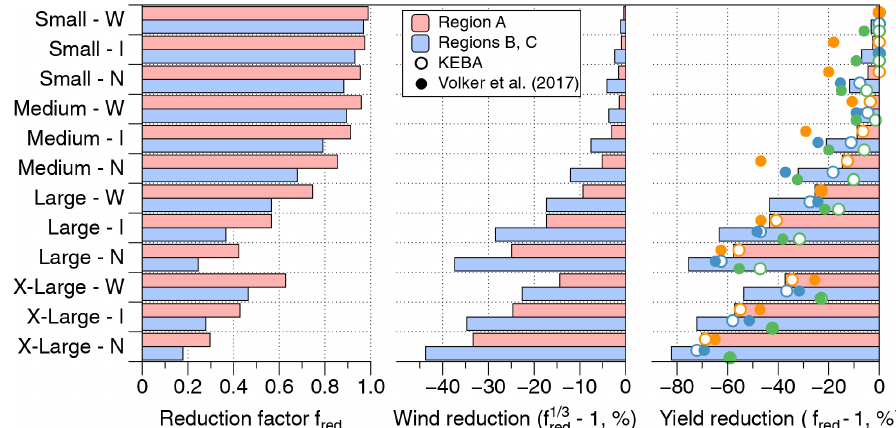
Figure 4. The value of the reduction factor f red for the case in which v < v rated (Eq. 9) for the different scenarios as well as the implied − 1, and the relative reduction of yield, f − 1, derived directly from the value of f relative reduction in wind speed, f 1 / 3 red red . The circles red in the right panel refer to the actual estimates that include the information of the wind speed histograms (open circles: KEBA; full circles: Volker et al., 2017), with the colour coding as in Fig.